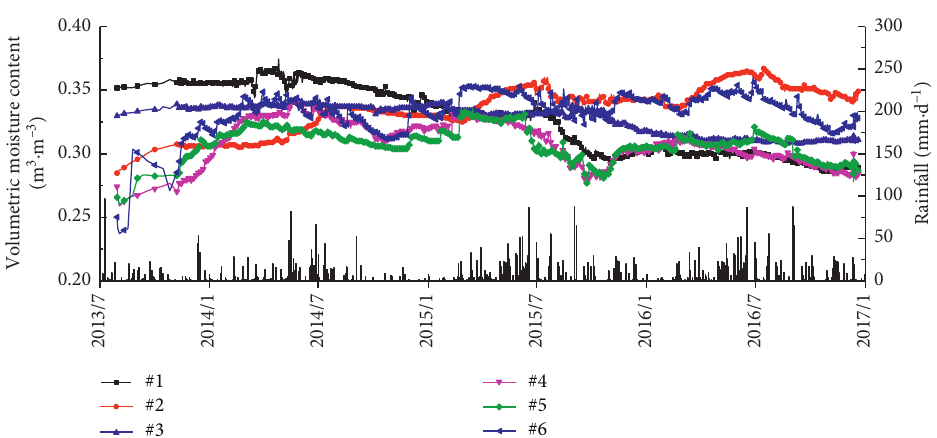
Figure 3: Volumetric moisture contents measured by the FDR sensors [23].